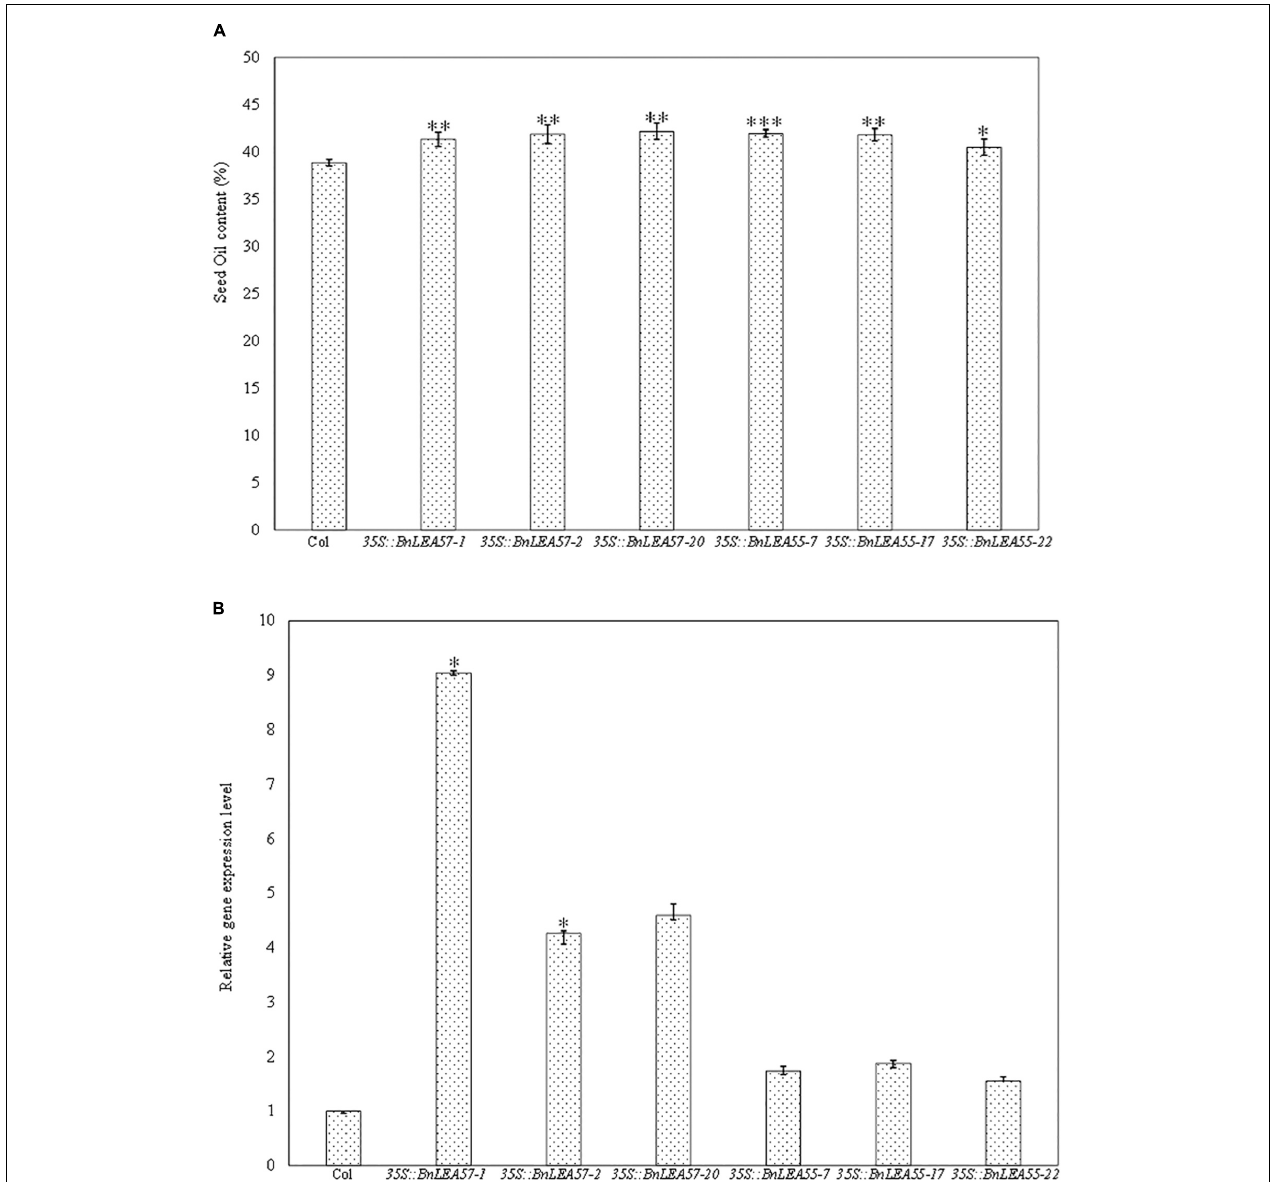
FIGURE 6 | Overexpression of BnLEA57 or BnLEA55 gene in Arabidopsis increased seed oil content. (A) Seed oil content in the Col-0 (WT) and different transgenic lines overexpressing BnLEA57 or BnLEA55 gene. (B) Relative gene expression level of BnLEA57 and BnLEA55 in different Arabidopsis transgenic lines. Error bars indicate standard deviation ( n = 3). Significant difference between the transgenic plants and wild type (Col-0) is indicated: ∗ for p < 0.05, ∗∗ for p < 0.01, and ∗∗∗ for p < 0.001 for Student’s t-test